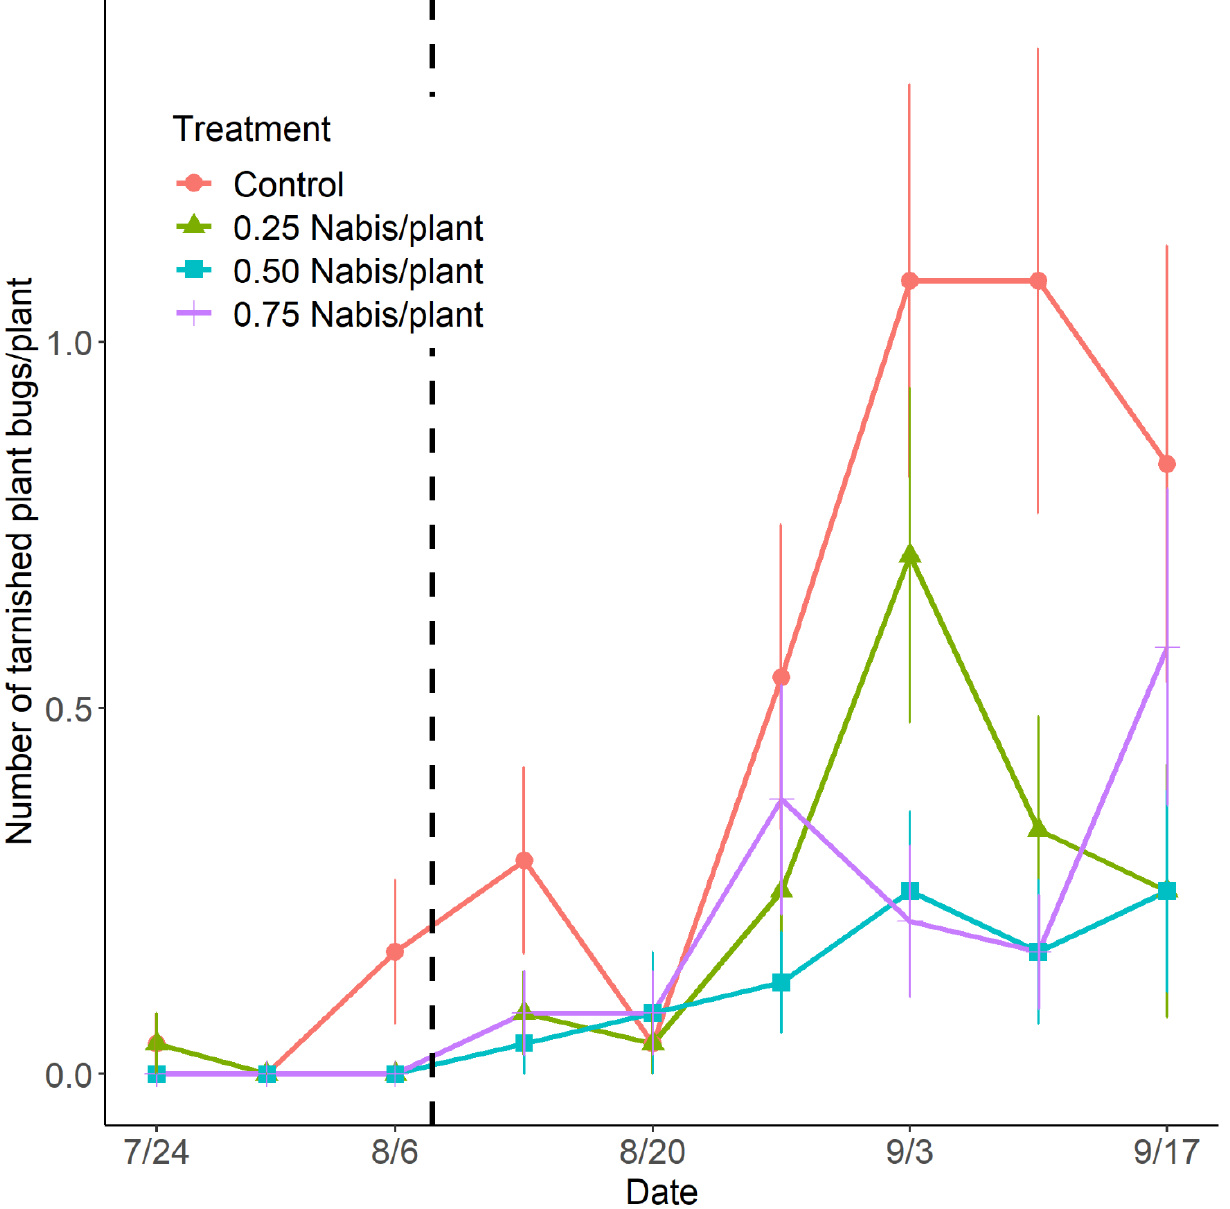
Figure 3. Seasonal variation in the tarnished plant bug population based on the rate of release of Nabis americoferus . The vertical line refers to the date of the predator’s release (8 August). The error bars correspond to standard errors.